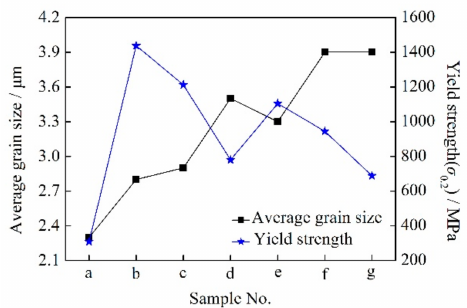
Figure 9. Relation of yield strength and average grain sizes of W-6Ni-4Co alloys by the di ff erent sintering processes: ( a ) 1200 ◦ C, 30 min; ( b ) 1450 ◦ C, 5 min; ( c ) 1450 ◦ C, 20 min; ( d ) 1450 ◦ C, 60 min; ( e ) 1500 ◦ C, 5 min; ( f ) 1500 ◦ C, 20 min; ( g ) 1500 ◦ C, 60